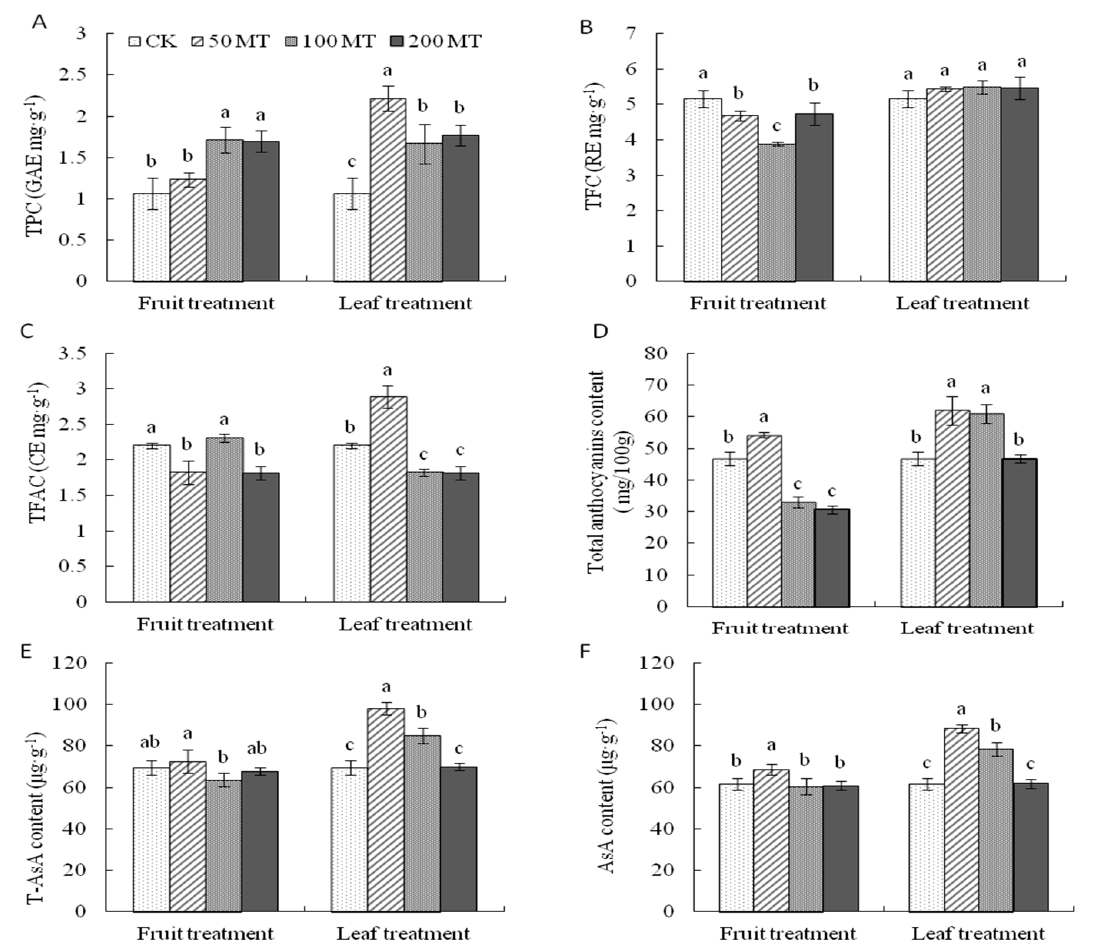
Figure 5. The changes of ( A ) total phenolics content (TPC), ( B ) total flavonoids content (TFC), ( C ) total flavanols content (TFAC), ( D ) total monomeric anthocyanins, ( E ) total ascorbic acid, and ( F ) ascorbic acid after exogenous melatonin application in Hongdeng sweet cherry. Data are shown as mean ± SE, with five biological replicates, different letters indicate significant differences at p < 0.05 level.